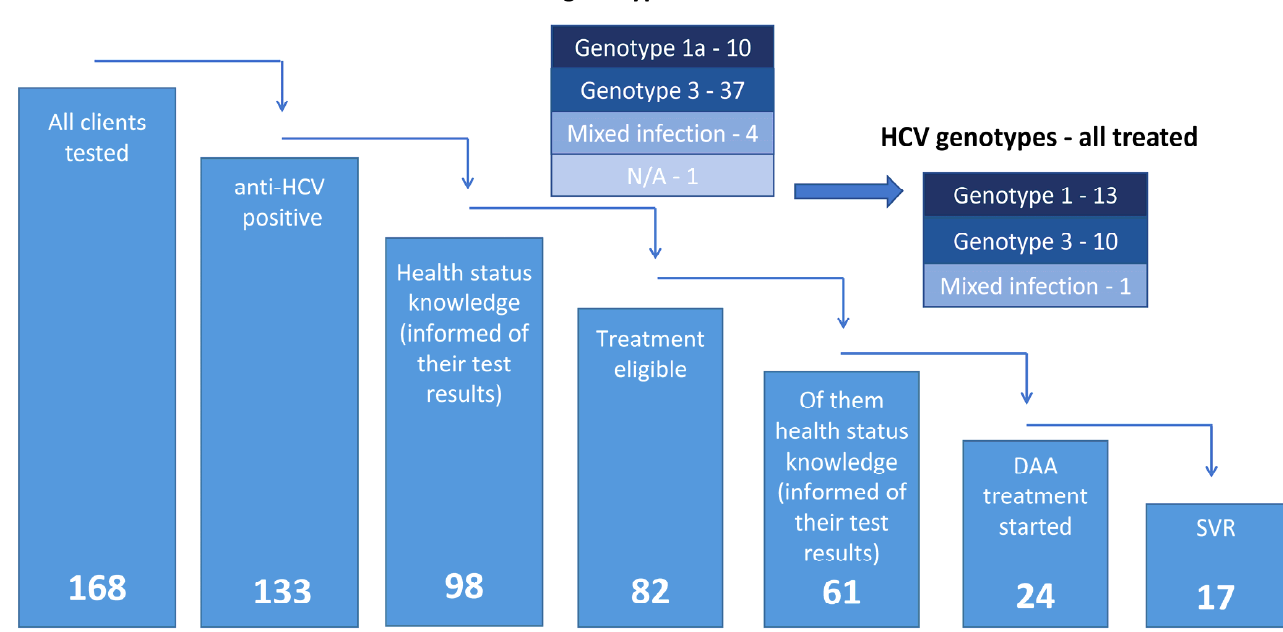
Figure 4. Cascade of care of the Remedis “Ambulance” outreach program. N/A—data not available (genotypes tested with uncertain results); DAA—direct-acting antivirals; SVR—sustained virological response defined as undetectable HCV RNA 12 weeks after treatment